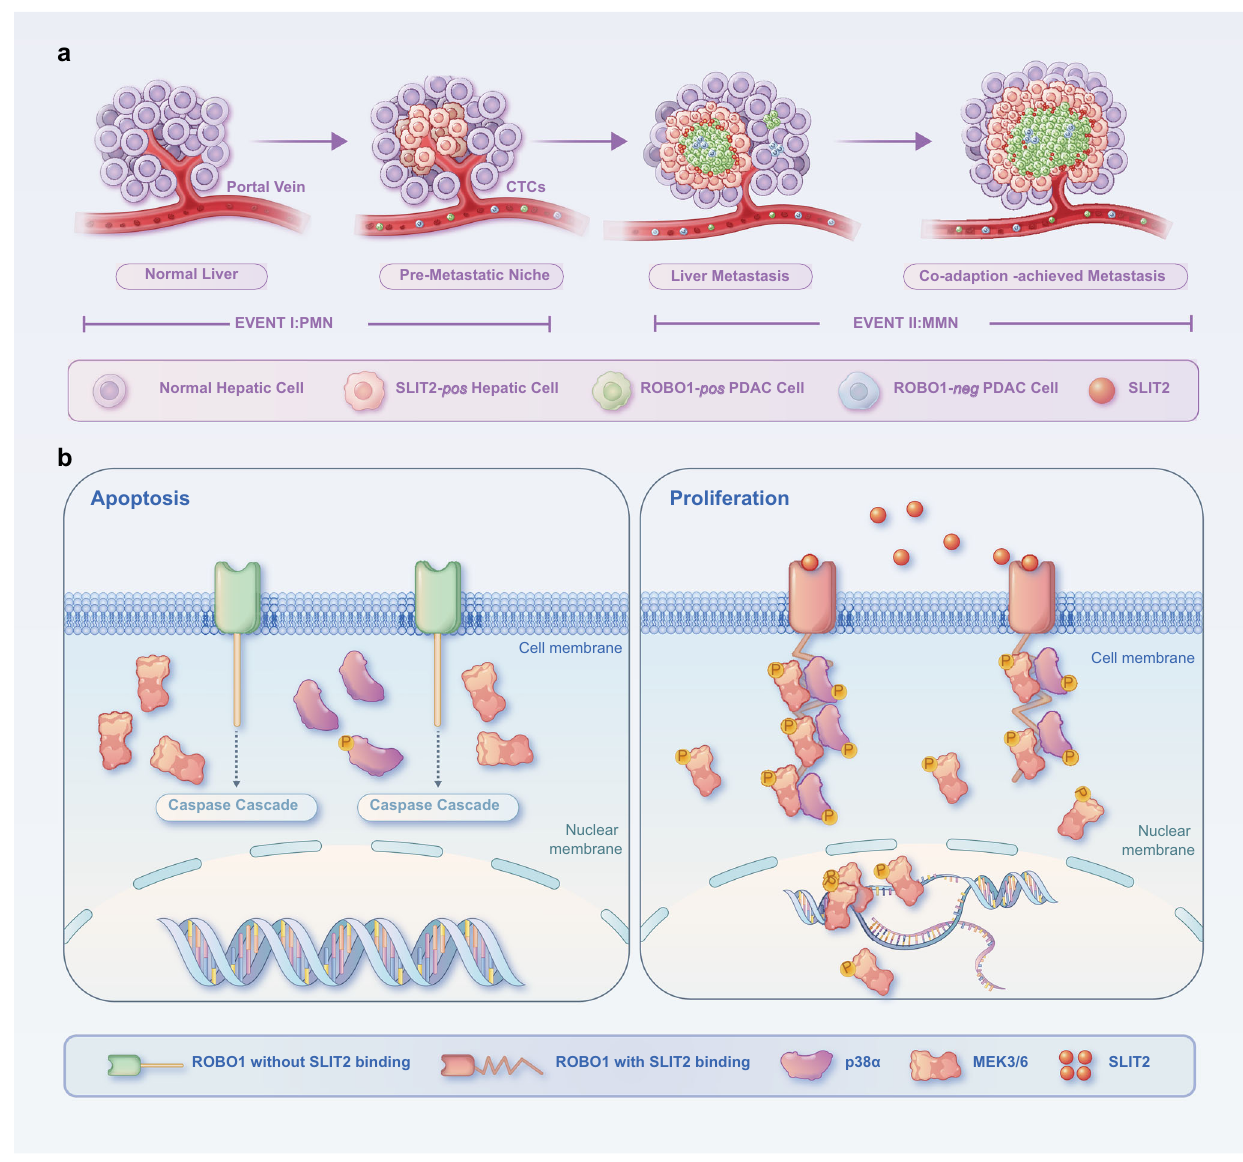
Fig. 8 | Summary model displaying the mechanism of the SLIT2-ROBO1 axis in PDAC liver metastasis and coadaptation. ( a ) Summary model displaying the process of SLIT2-ROBO1-mediated coadaptation of hepatic cells and tumour cells, which promotes metastatic niche outgrowth in PDAC. b Summary model showing